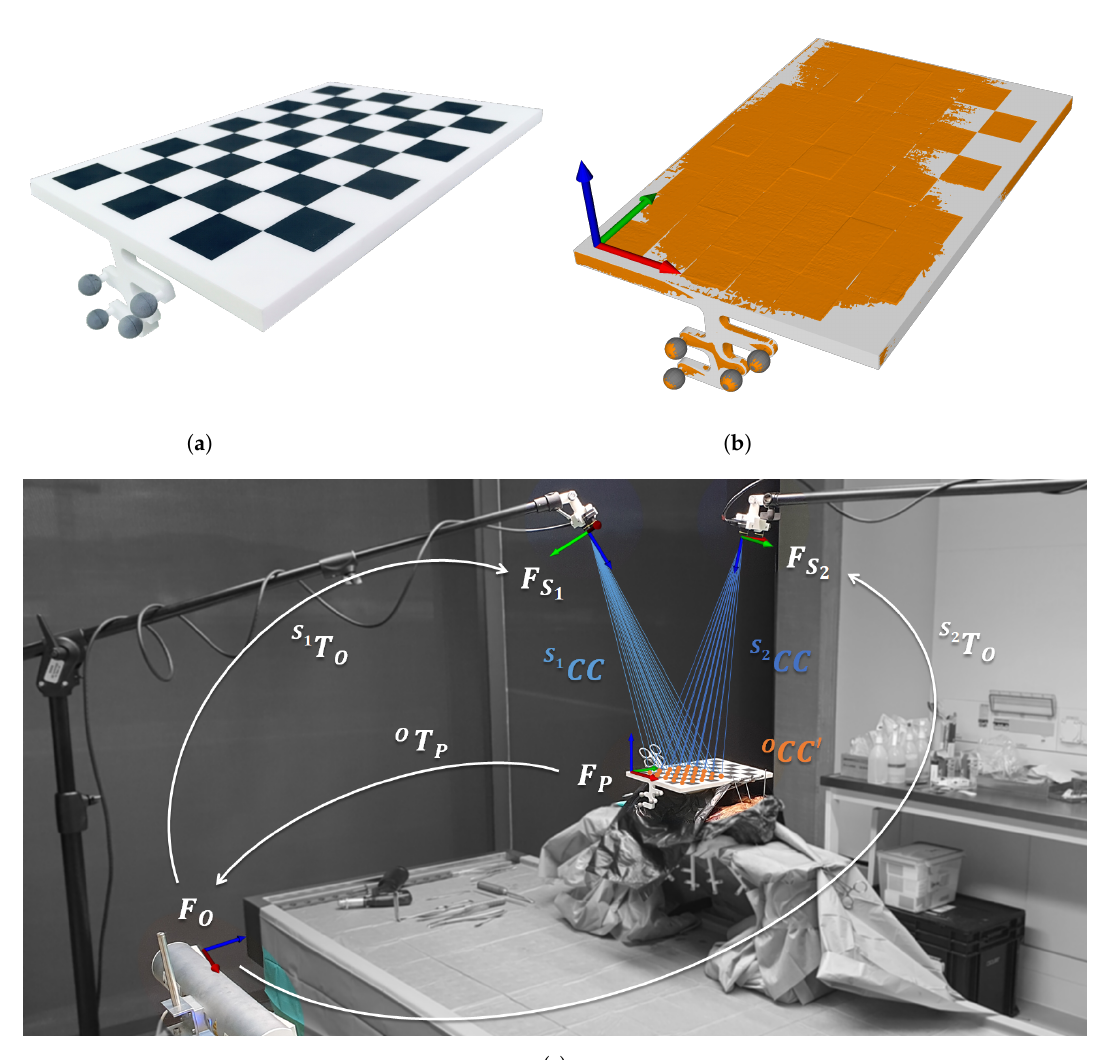
Figure 2. Extrinsic calibration materials and process. ( a ) 3D printed and painted calibration phantom with infrared-reflecting spheres mounted. ( b ) CT-extracted calibration phantom 3D model (orange), aligned re-calibrated marker geometry 3D model combined from generic sphere 3D models of true size (gray) and aligned CAD-exported calibration board 3D model (white) with its chessboard pattern origin w.r.t. which the four sphere centers (gray) were stored as the re-calibrated marker geometry. ( c ) Calibration phantom positioned on top of the anatomy such that optical tracking system (OTS; F O ) and RGB-D sensors ( F S , F S ) can detect their respective part. 25 chessboard corners detected by either RGB-D sensor ( S 1 CC , S 2 CC ) 2 1 and their respective OTS counterparts ( O CC (cid:48) ), found by multiplying the ground truth 3D chessboard corners with O T P . Transformations S 1 T O and S 2 T O are found by Equation